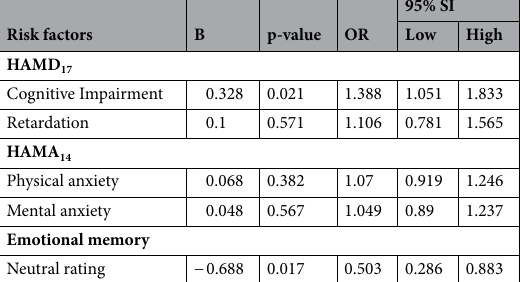
Table 4. Without suicidal ideation group and with suicidal ideation group dual logistic regression analysis of risk factors for suicidal ideation (n = 86). Statistical significance was set at p < 0.05. B regression coefficient, OR odds ratio, CI confidence